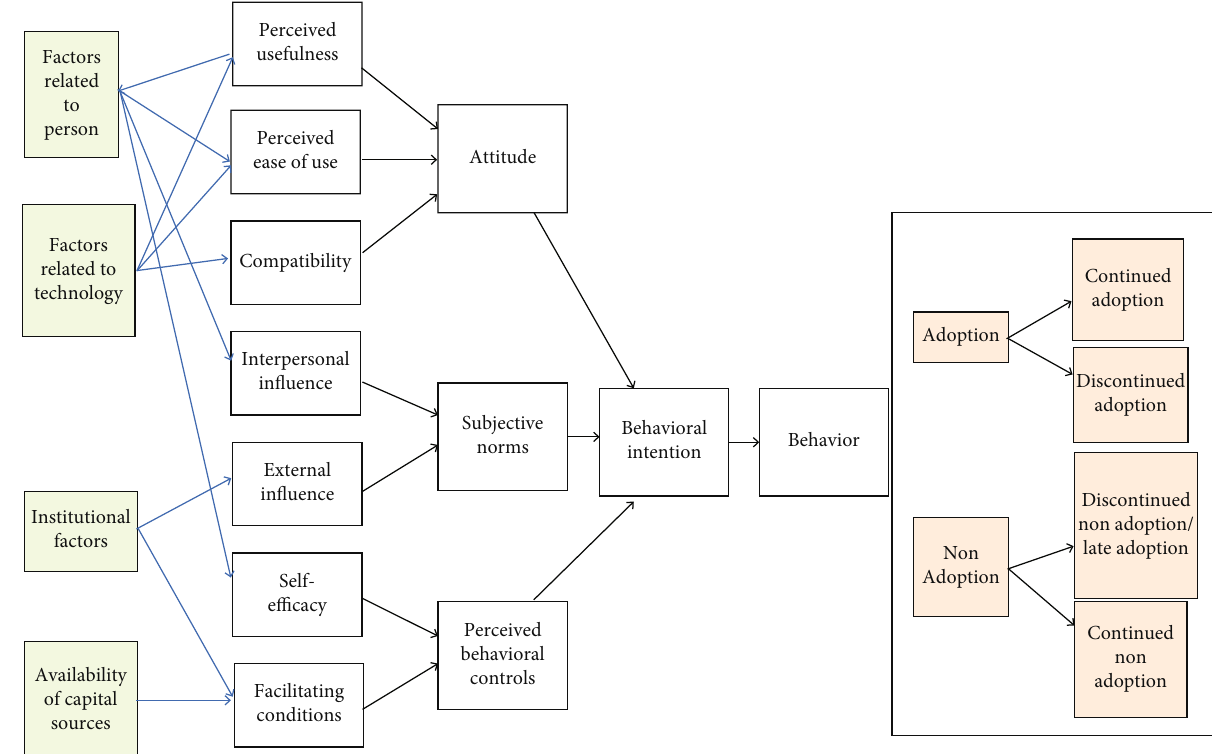
Figure 19: A collective approach model on technology